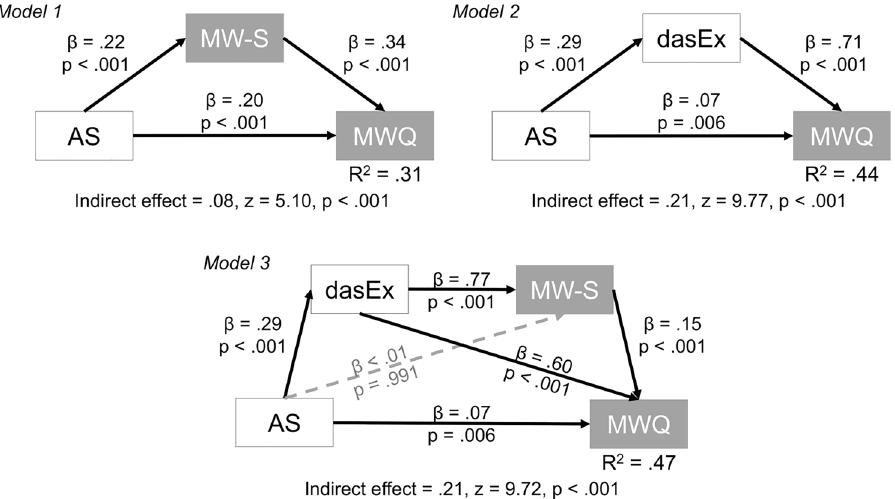
Figure 2. Mediation Analyses of the Relationship Between the Apathy Scale and Mind Wandering Questionnaire. Note Two mediators were considered, namely, the spontaneous mind wandering scale (Model 1) and executive subscale of DAS (Model 2). Model 3 incorporated them simultaneously. AS = apathy scale; MW-S = spontaneous MW scale, MWQ = mind wandering questionnaire; DAS = dimensional apathy scale and dasEx = executive subcomponent of